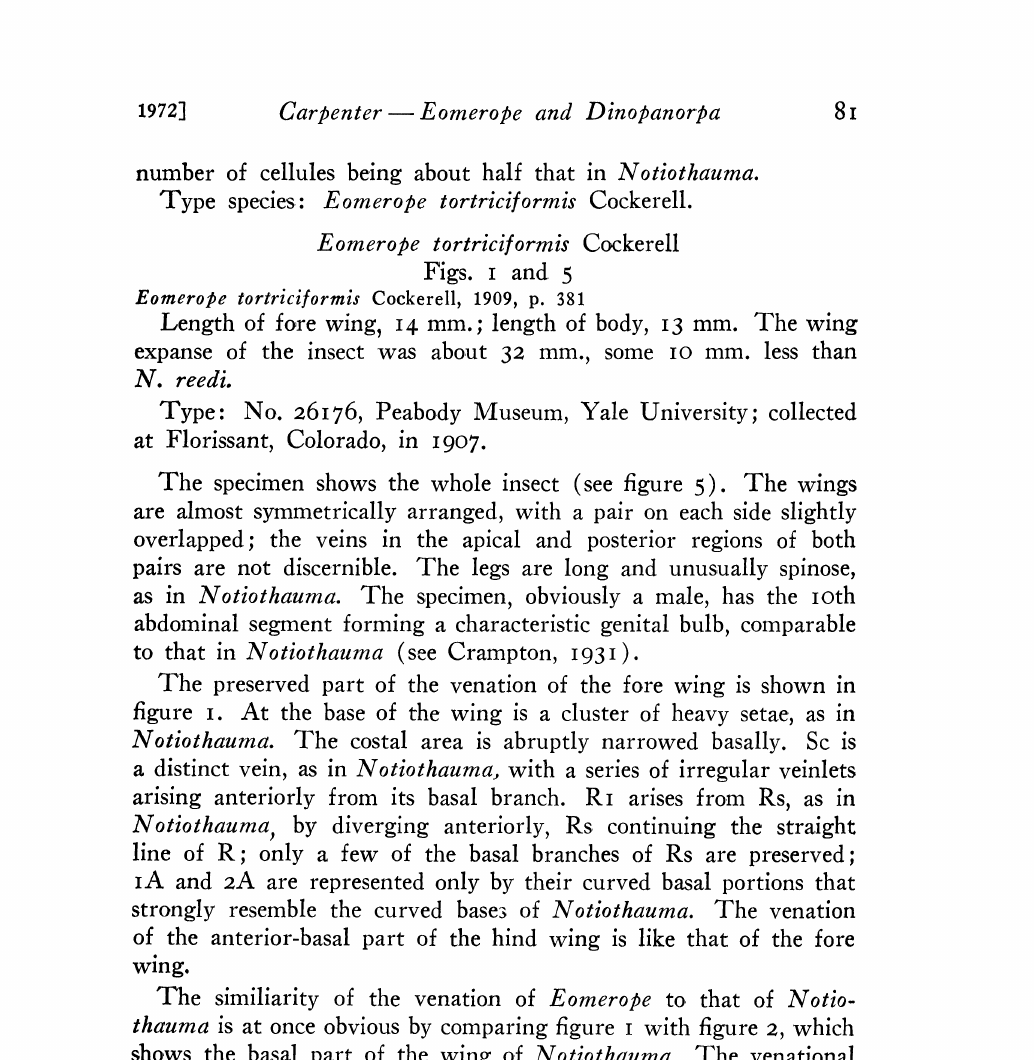
Figure 1. Eomerope tortriciormis Cockerell; drawing of preserved part of fore wing, based on holotype (original). Figure 2. Notiothauma reedi MacLachlan; drawing of proximal part of fore wing (after Cramp,ton, 1930). Figure 3. .Merope tuber Newman; drawing of proximal part of fore wing (original). Figure 4. ./lustromero#e #oultoni Killington; drawing of proximal part of fore wing (after Killington,